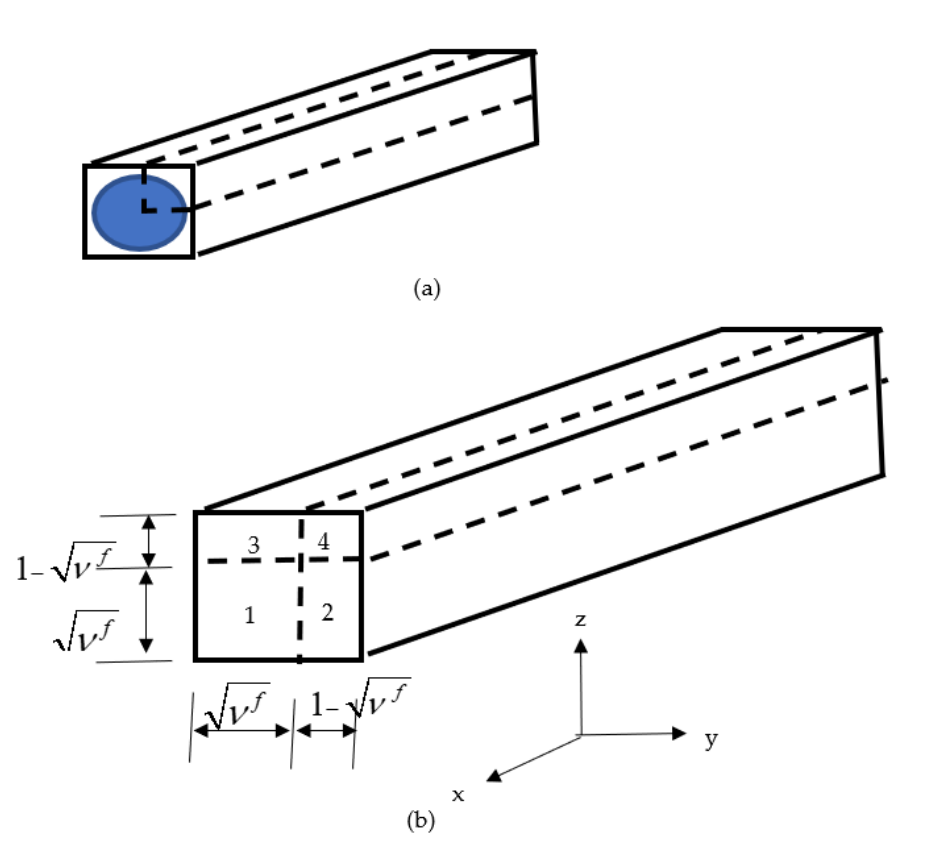
Figure 2. Unit-cell model: ( a ) full geometry and ( b ) quarter model (the x -axis is the fiber orientation, and ν f denotes the fiber volume fraction).